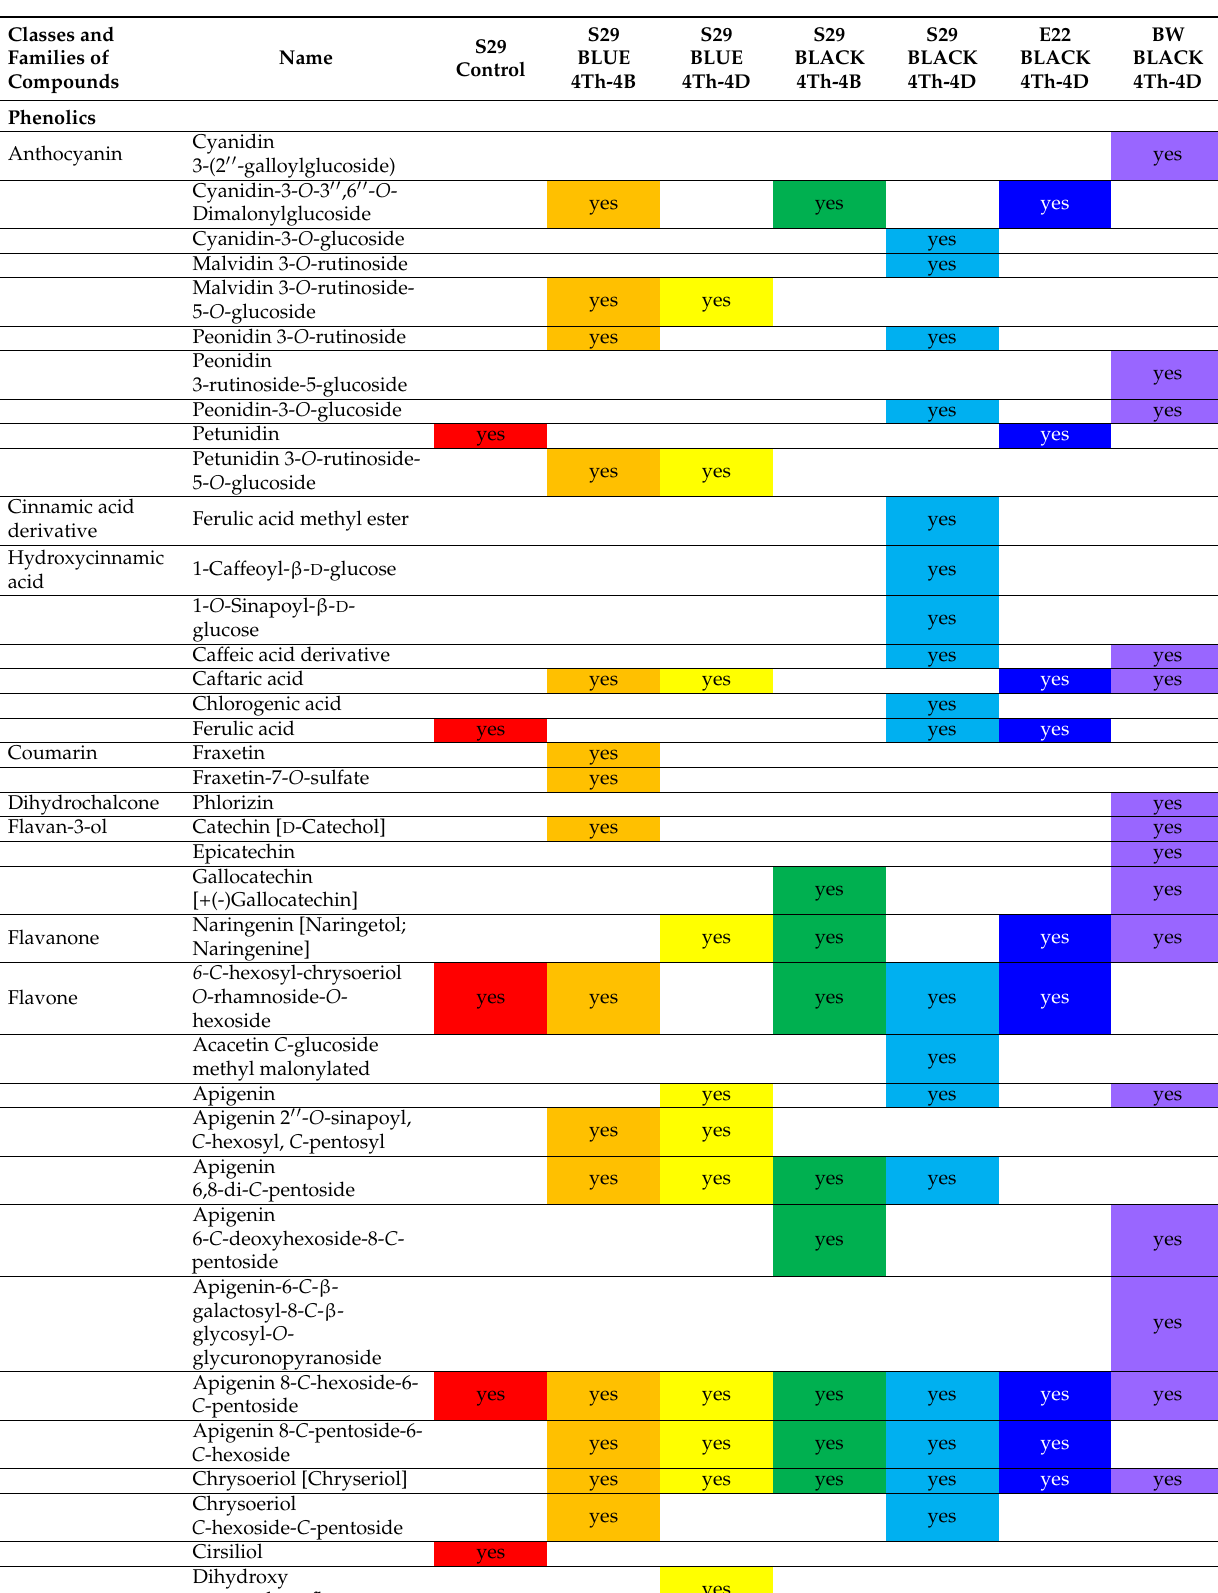
Table 1. A detailed table of the biologically active substances found in the analyzed colored-grain lines of the wheat T. aestivum . Different color marks the presence of certain compounds in particular